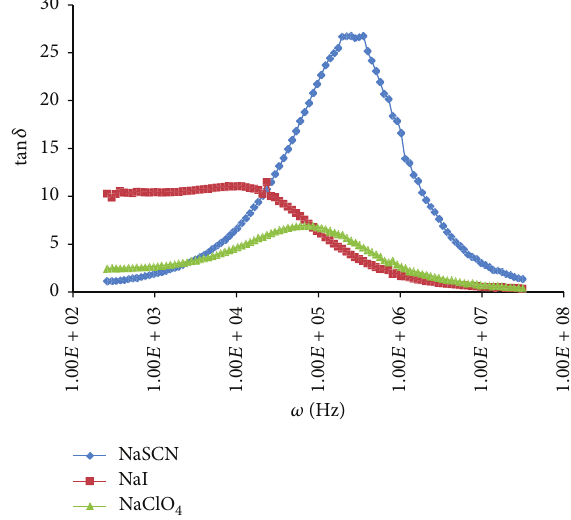
, 𝑀 , 𝜇 , and 𝑁 for different salt (NaClO ep